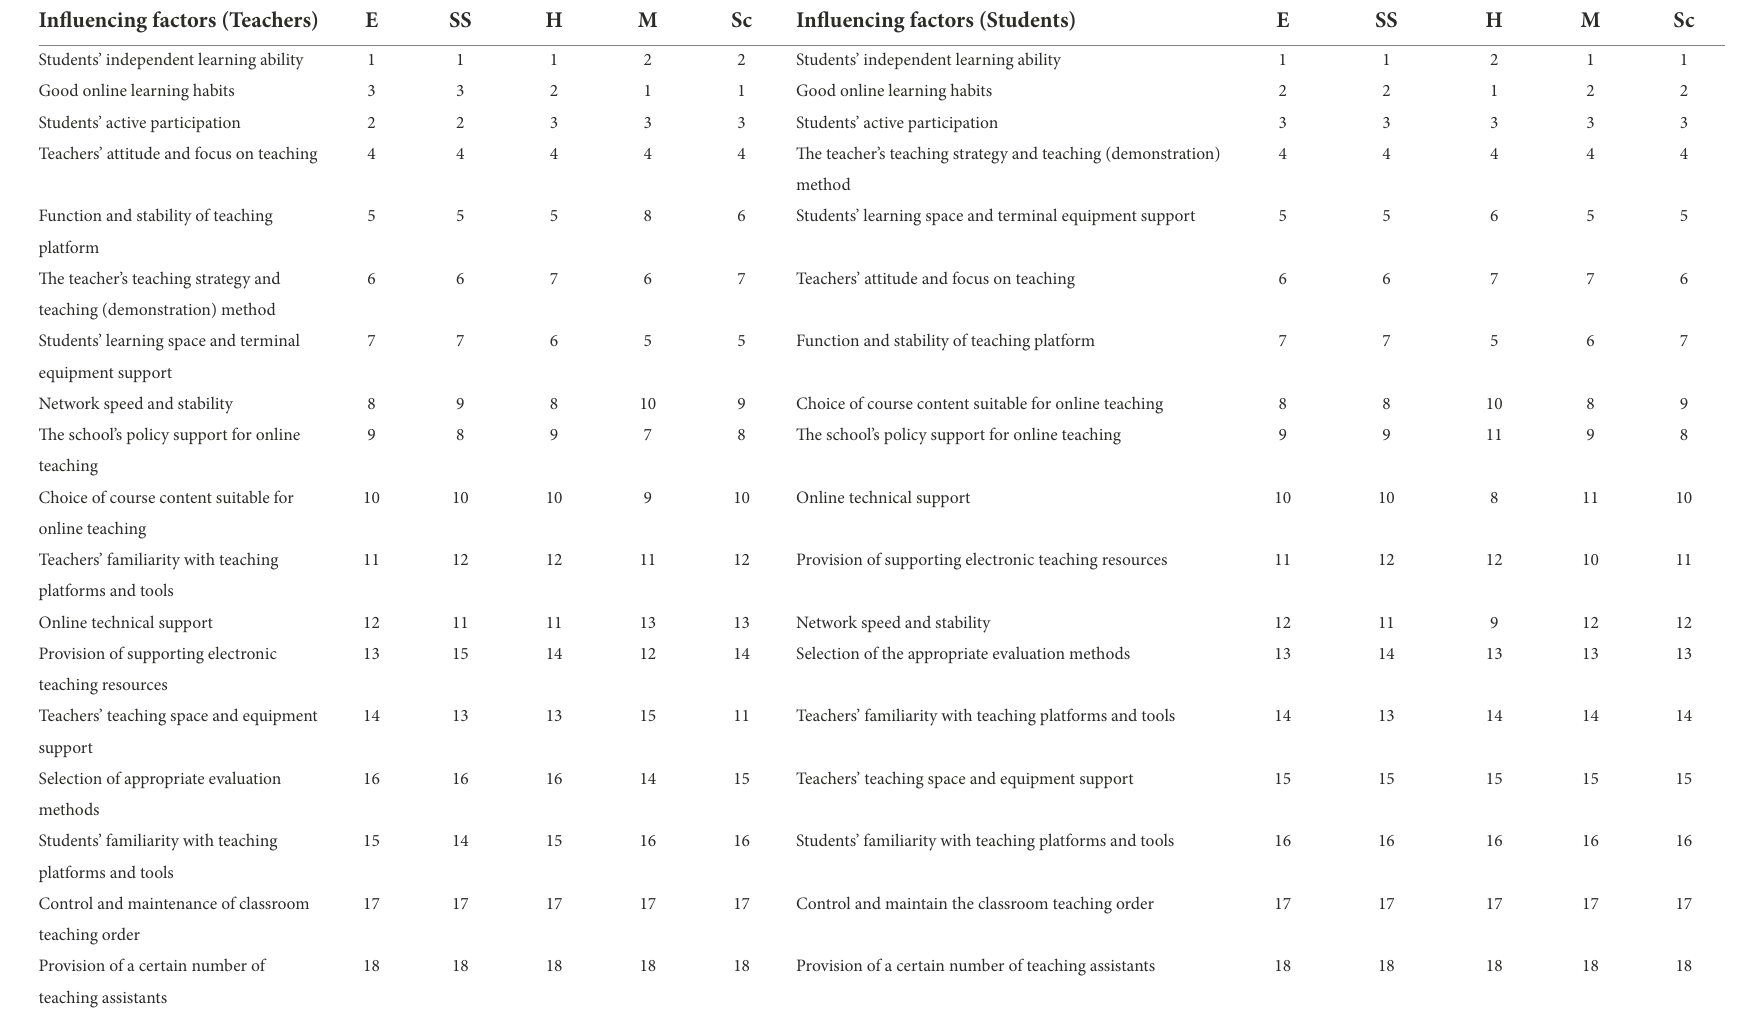
TABLE 2 Evaluation of online education influencing factors by teachers of various